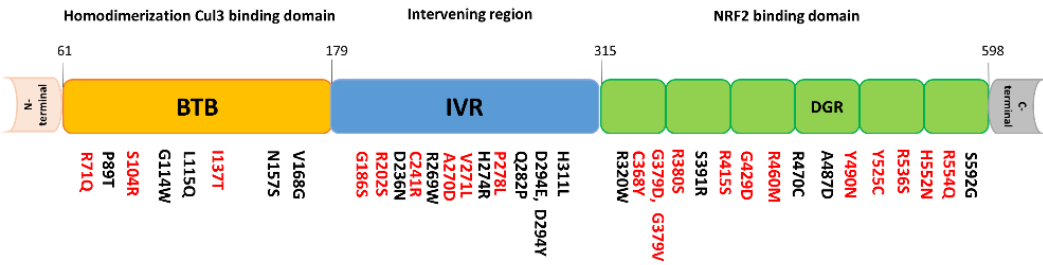
Figure 1. Human Kelch-like ECH-associated protein 1 (KEAP1) mutations (liver cancer) identified by the International Cancer Genome Consortium. The amino acid positions of the identified mutations of KEAP1 are shown and the amino acid positions in red color indicate the location of mutations that are conserved among several species (Human, Mouse, Bovine, and Zebrafish). The 61 BTB 179 domain is required for homodimerization of Keap1 by interactions with the Cul3 based E3 ubiquitin ligase system. The 315 DGR 598 or 6 Kelch-repeat domain binds to NRF2 through Neh2 domain of NRF2. 180 IVR 314 domain between BTB and DGR domain important sensing oxidative stress and xenobiotic stimuli via modification of its four cysteine residues by electrophiles.